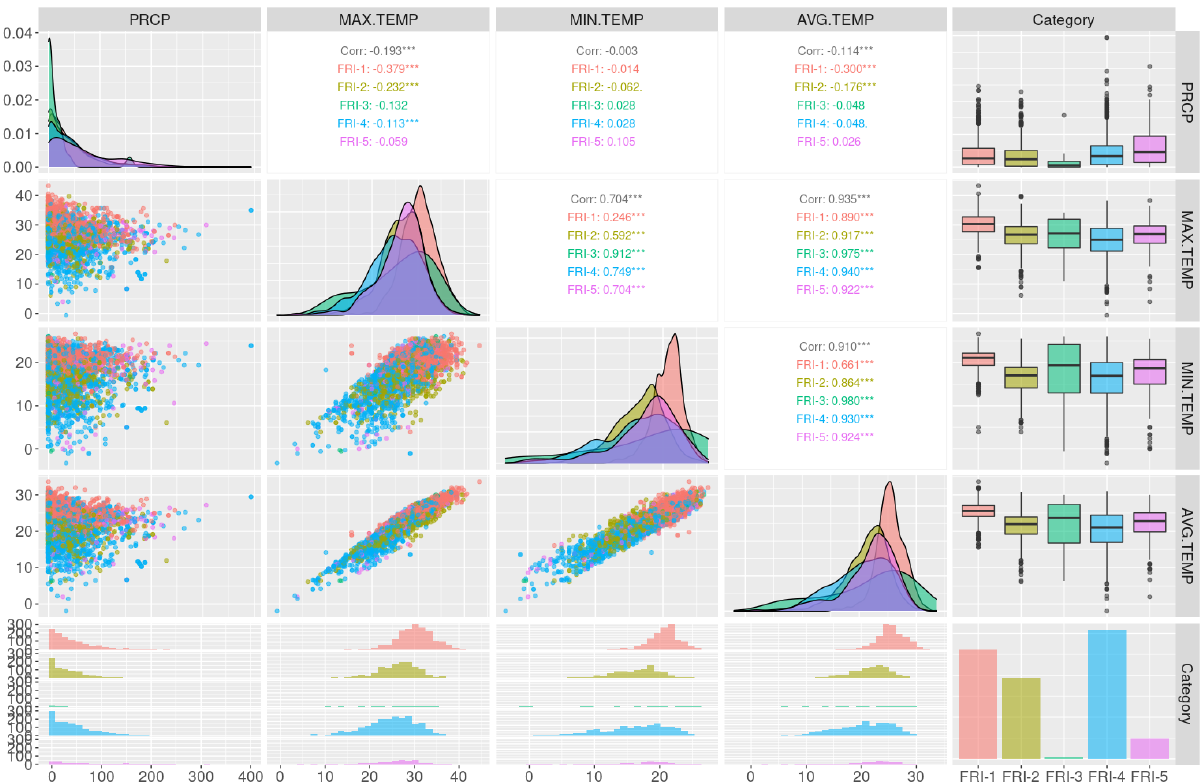
Figure 4. Exploratory and sensitivity data analysis of the climate information, and the FRI variables used in the prediction framework.